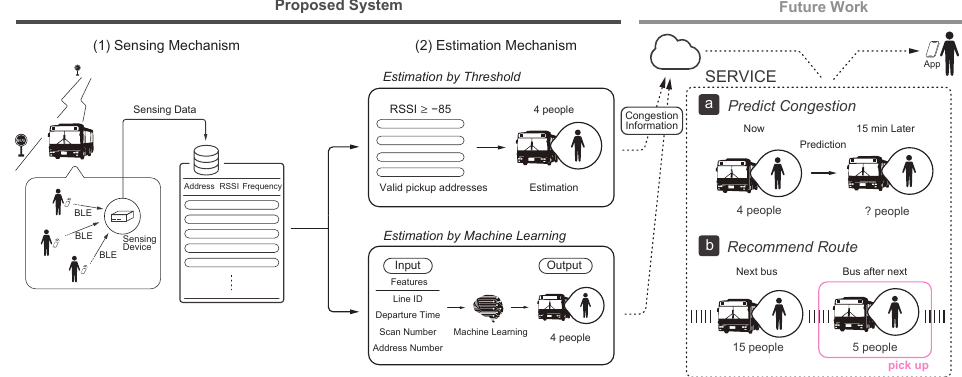
Figure 1. Schematic diagram of the proposed